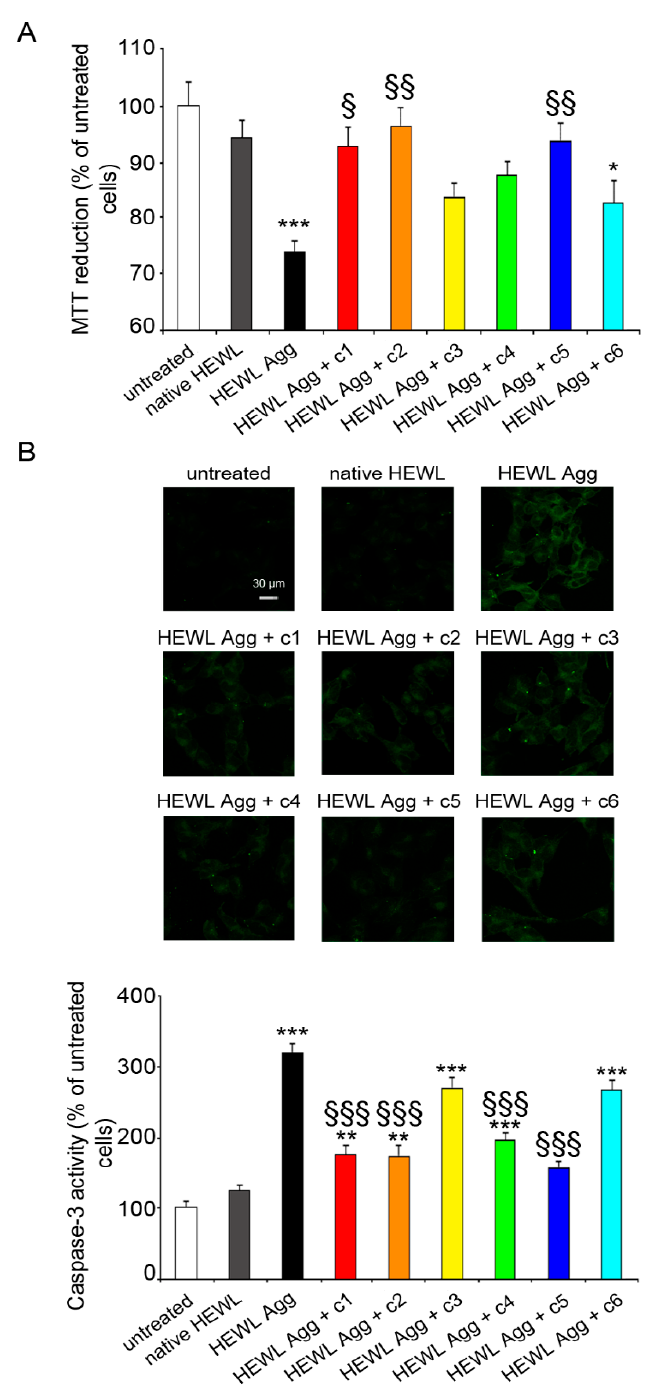
Figure 7. Impairment of cell viability after exposure to HEWL aggregates. ( A ) MTT reduction in SH-SY5Y cells treated for 24 h with 2 µ M (monomer equivalents) HEWL aggregates formed in the absence or presence of the indicated compounds. ( B ) Caspase-3 activity in SH-SY5Y cells treated for 24 h with 2 µ M HEWL aggregates formed in the absence or presence of the indicated compounds. The green fluorescence arises from intracellular caspase-3 activity. The results of a semi-quantitative analysis of the caspase-3-derived fluorescence data are expressed as the percentage of the value for untreated cells. In both panels, experimental errors are standard error of mean (S.E.M). Samples were analyzed by one-way ANOVA followed by Bonferroni’s multiple comparison test relative to untreated cells (* p < 0.05, ** p < 0.01, *** p < 0.001), or to cells treated with HEWL aggregates in the absence of compounds (§ p < 0.05, §§ p < 0.01, §§§ p < 0.001).